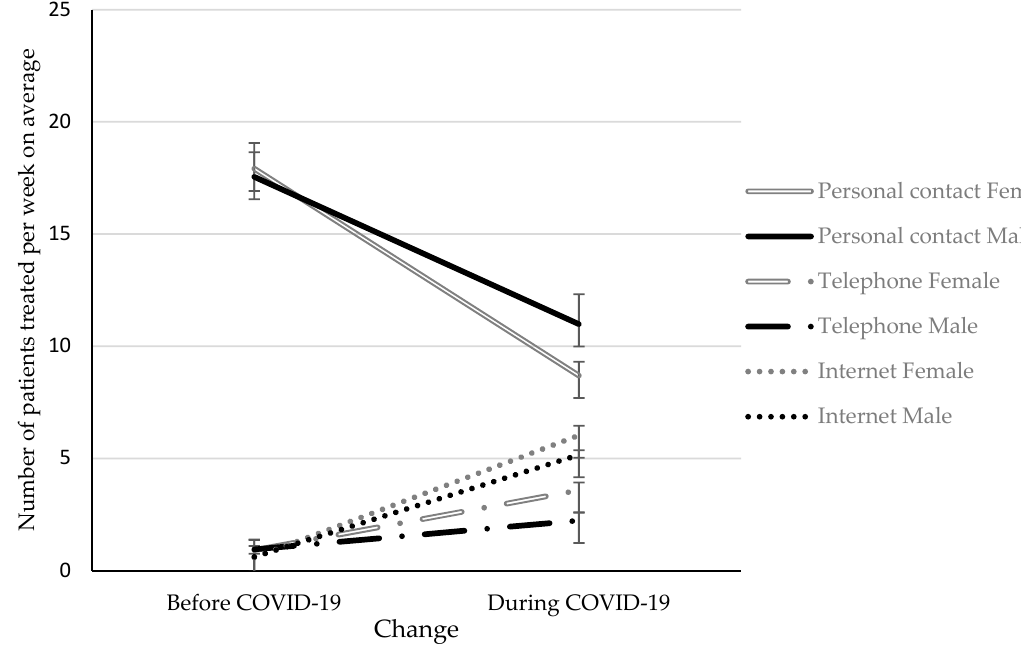
Figure 2. Average number of patients treated per week in personal contact, via telephone or via Internet in the months before / during the COVID-19 situation in female and male psychotherapists averaged among participating countries. Mean ± standard error.